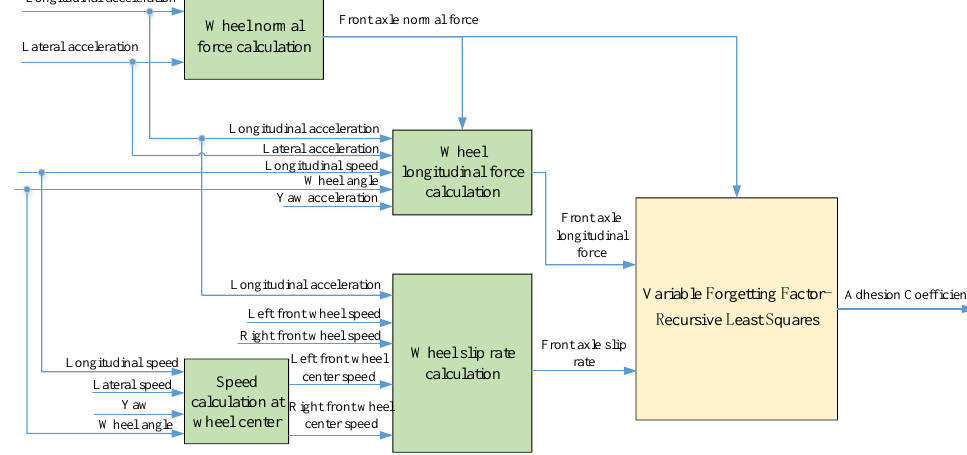
Figure 6. Road friction coefficient calculation process.